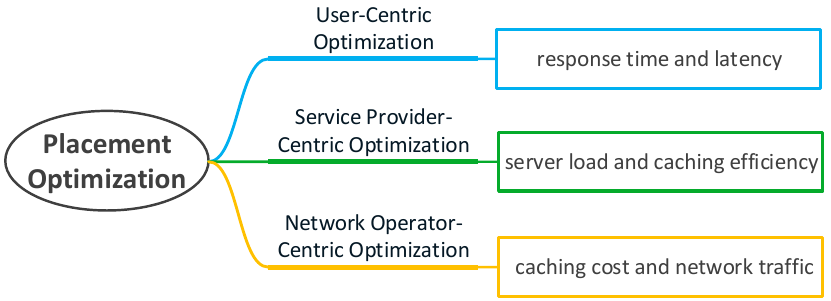
Figure 2. Placement